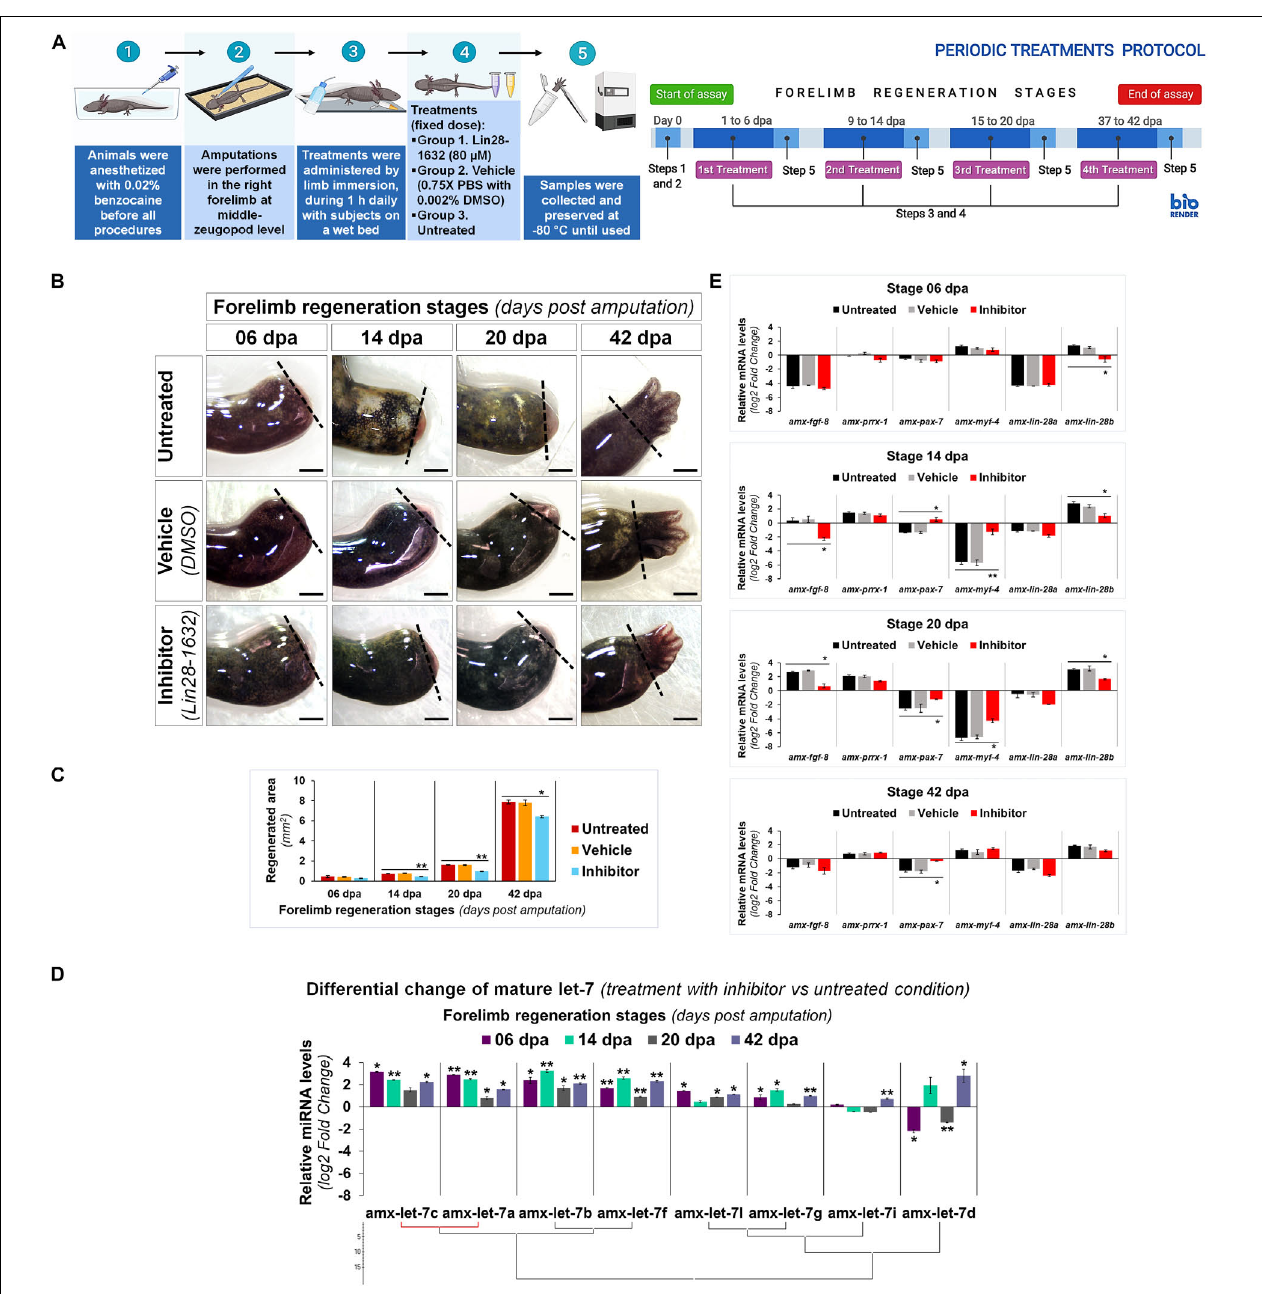
FIGURE 6 | Characterization of induced effects after Lin28 inhibition in key regeneration stages. (A) Schematic diagram of the periodic administration protocol followed; on the left side, it shows the general strategy implemented, and on the right side, the temporary management schedule to each regeneration stage of interest. Created with BioRender. (B) Morphological changes observed after administration of different treatments in most representative stages of regeneration. Dotted lines indicate the amputation site. Scale bars: 1 mm. (C) Morphometric analysis of regenerated areas to conditions assayed. (D) Differential change in maturation patterns of the let-7 family in representative regeneration stages after treatments with inhibitor (vs respective stages untreated). Hierarchical clustering of Ward with Manhattan distance measurement, marking in red a positive Pearson correlation of P < 0.05. (E) Relative transcript abundances of some genetic markers during key stages of limb epimorphosis. Data in the graphs are represented as mean ± s.e.m. ( n = 3); *, P < 0.05; **, P < 0.01; one-way ANOVA with post hoc Dunnett test vs untreated control condition.